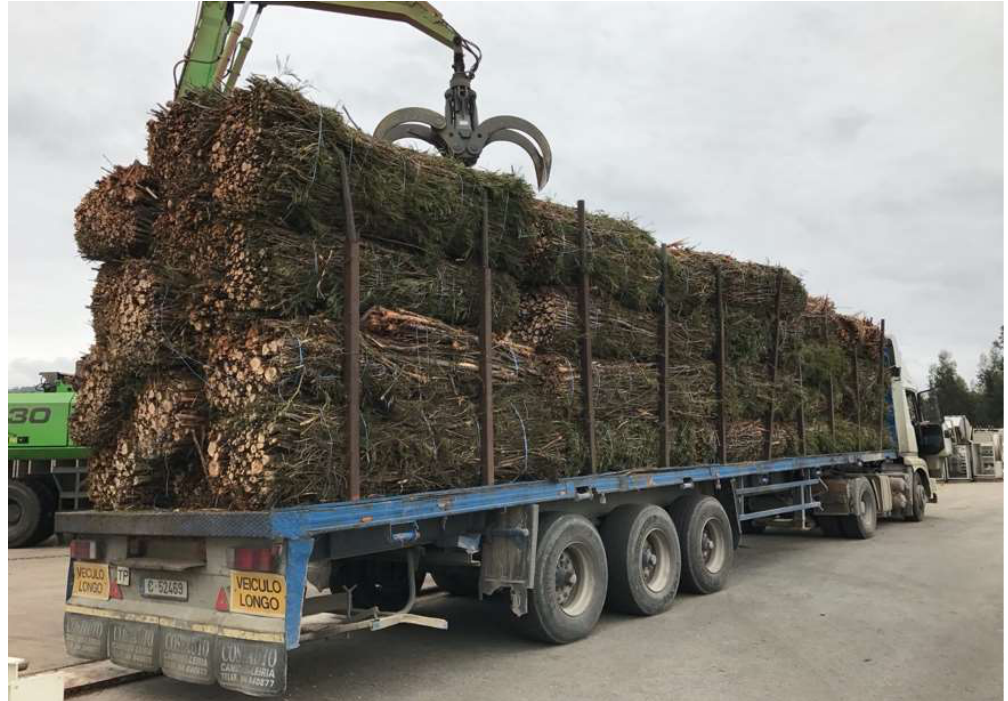
Figure 1. The material was cut and baled in order to facilitate transport, but also to ensure that all the material collected on the ground was transported to the company for weighing, processing, and